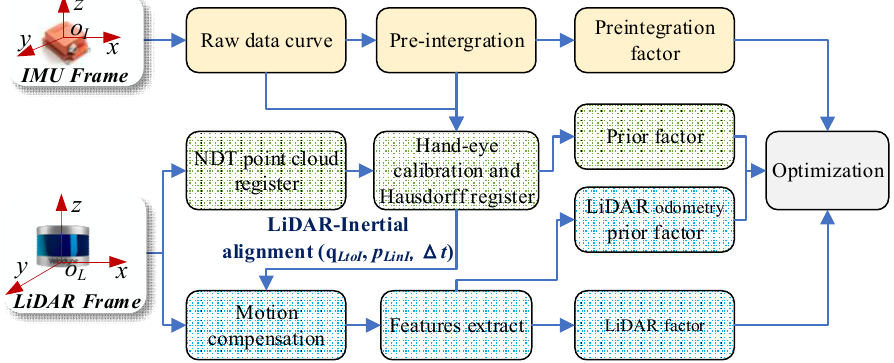
Figure 3. Block diagram of multisensor spatiotemporal calibration.